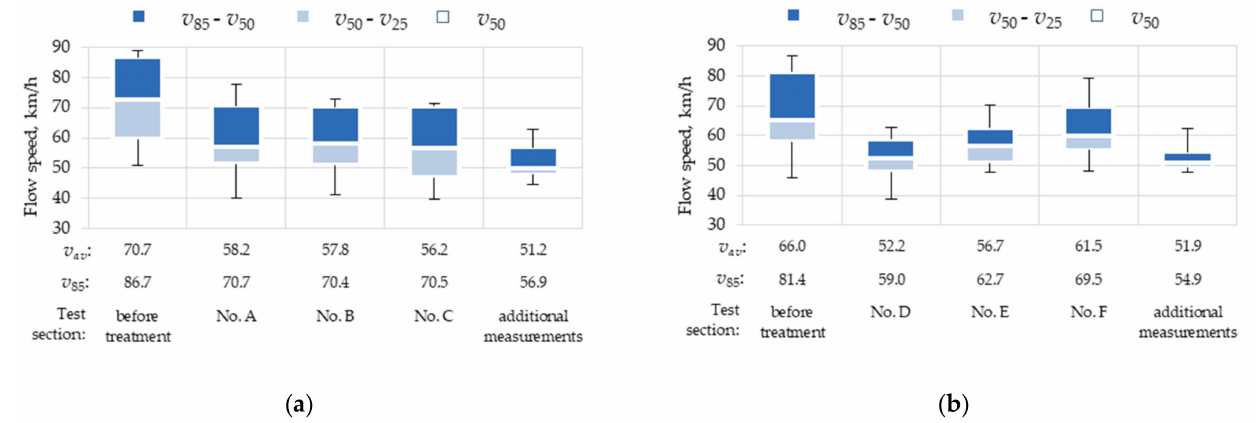
Figure 8. Estimated speed ranges in km/h: ( a ) On the test sections on the westbound carriageway preceded by a ca. 600 m long straight section of the road; ( b ) on the test sections on the eastbound carriageway preceded by a ca. 130 m long straight section of the road.